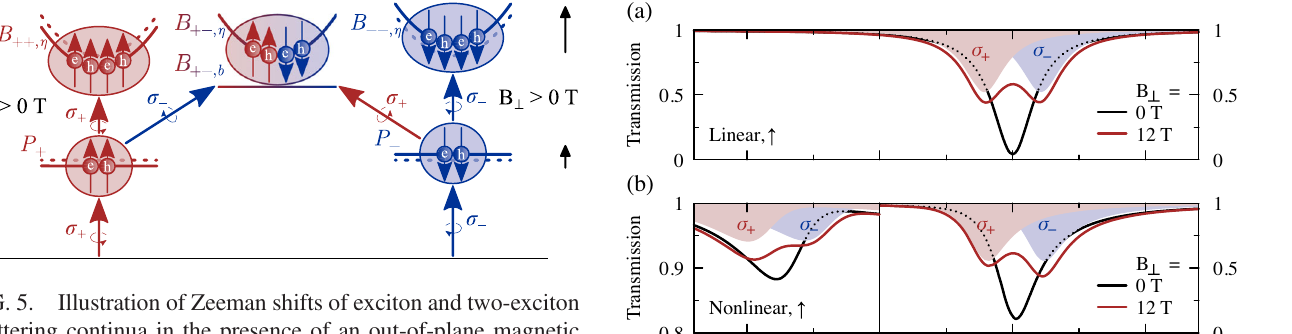
and σ − polarized þ